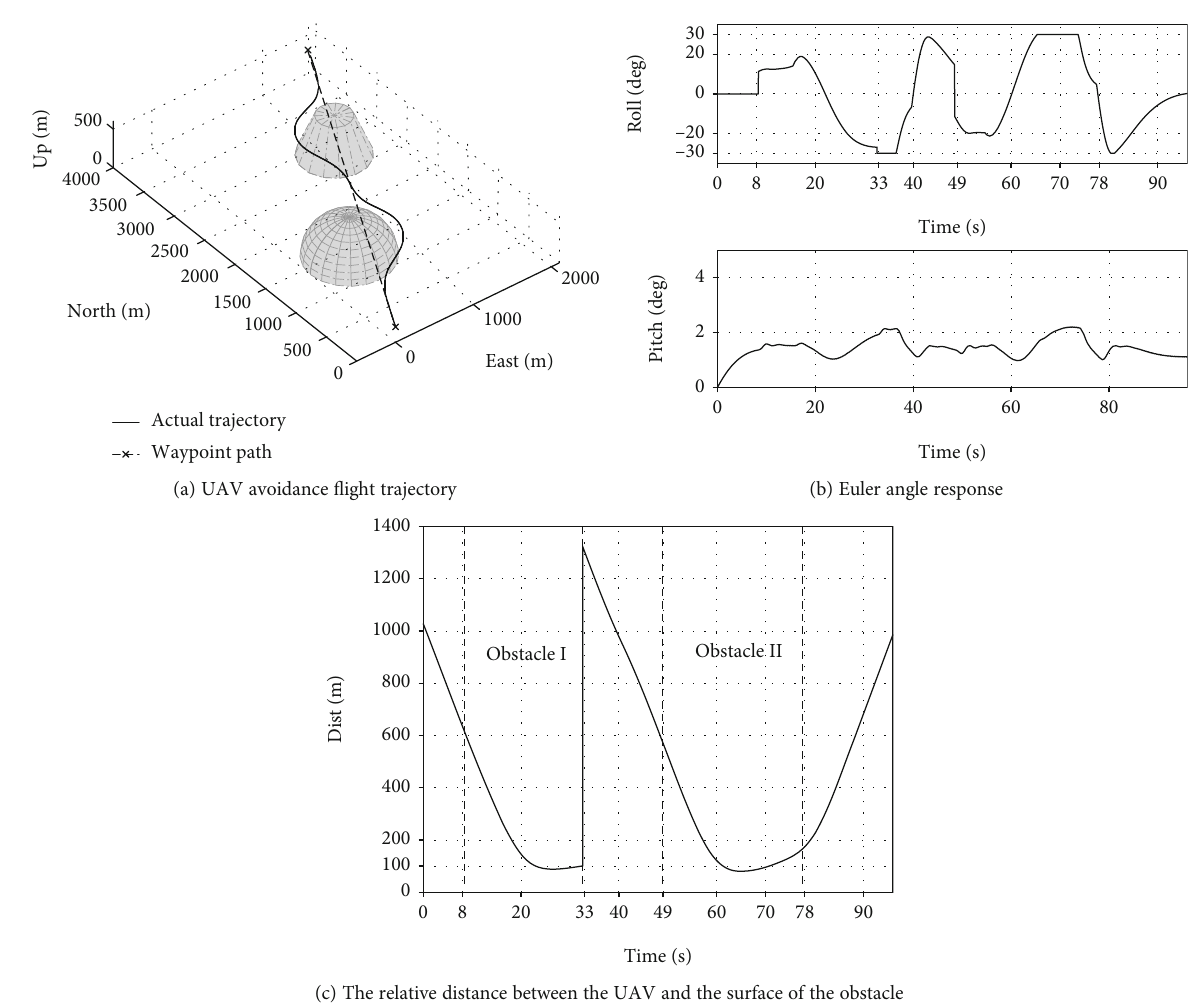
Figure 10: UAV fl ight status of simple obstacle avoidance